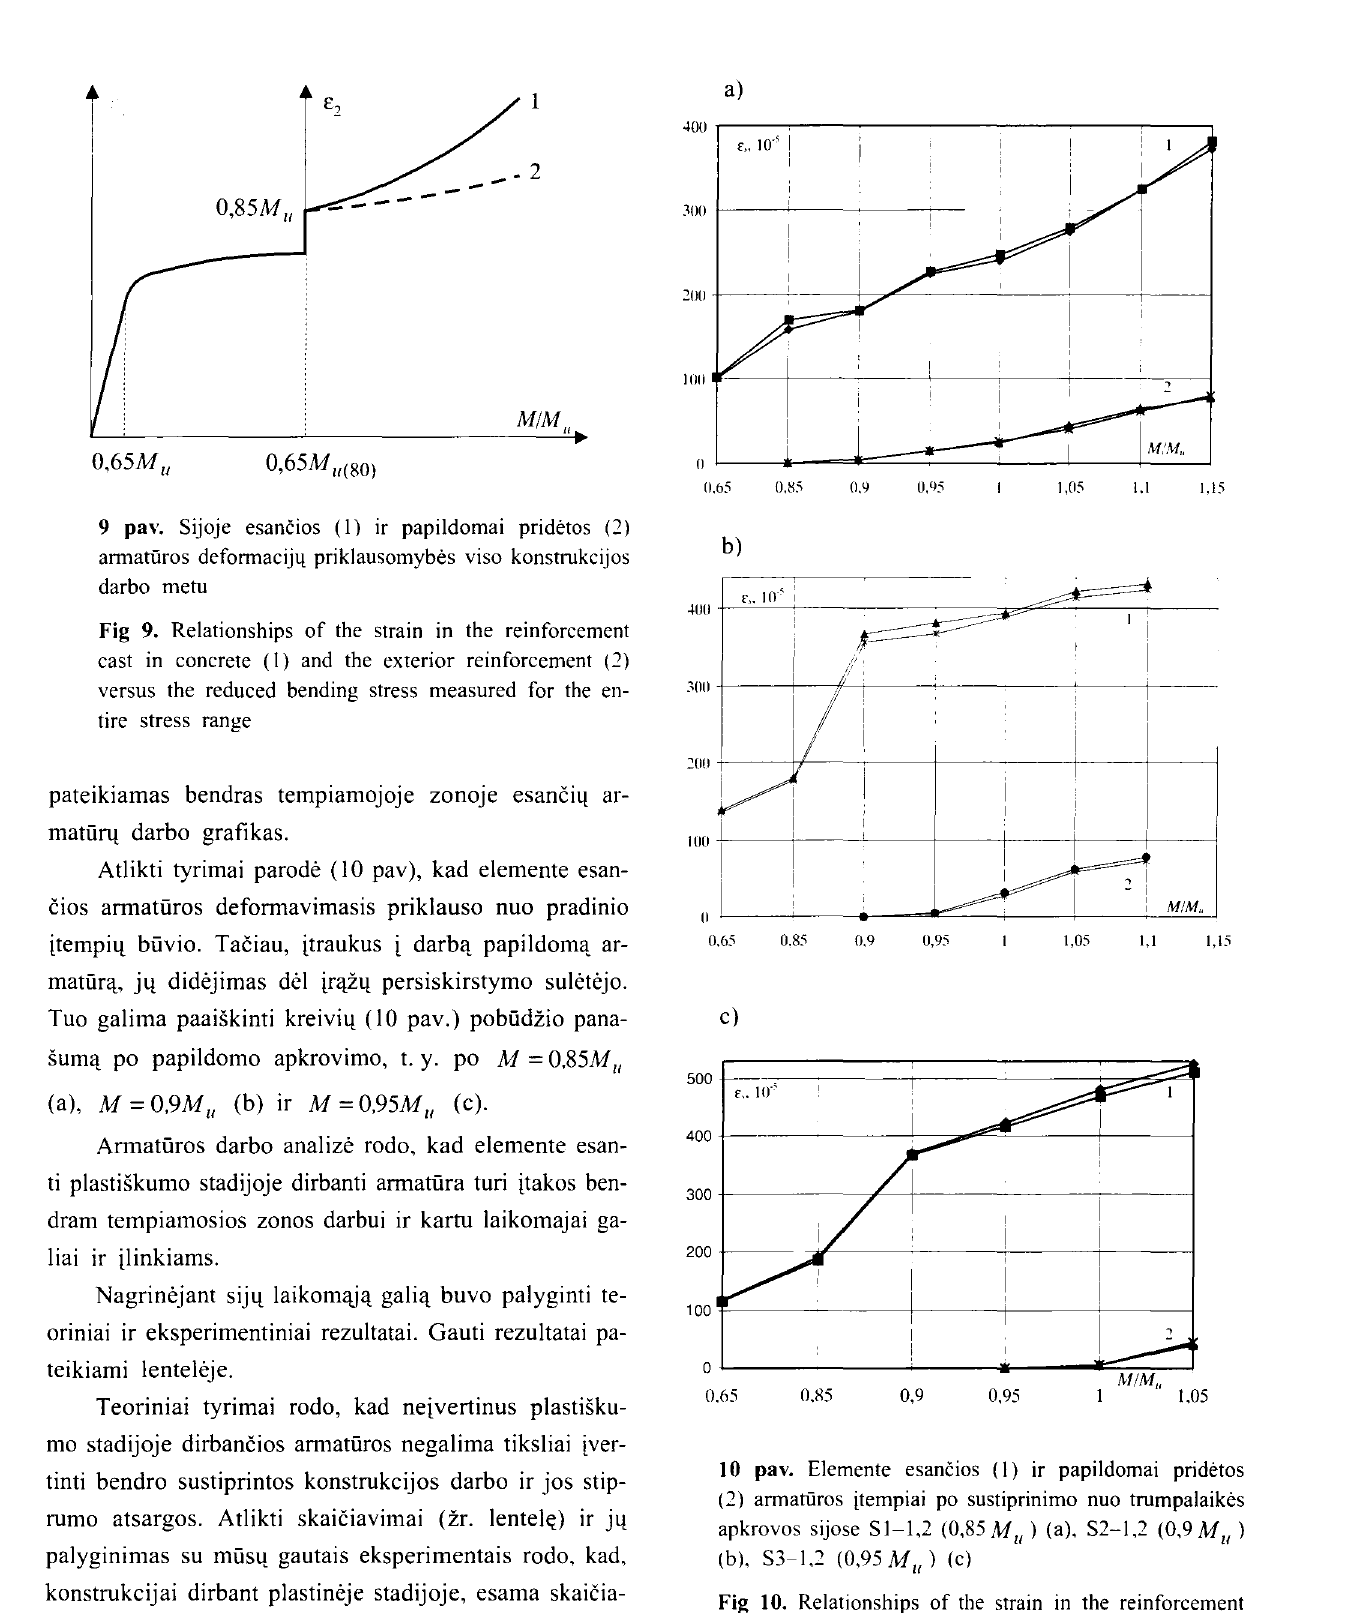
(2) armatliros itempiai po sustiprinimo nuo trumpalaikes apkrovos sijose Sl-1,2 (0,85 M (a). S2-1,2 (0,9 M 11 ) 11 ) (b). S3-L2 (0.95 M (c) 11 ) Fig 10. Relationships of the strain in the reinforcement cast in concrete (I) and the exterior reinforcement (2) versus the reduced bending stress measured during the application of short-term loads after strengthening: beams Sl-1,2 (0.85 M (a), beams S2-L2 (0.9 M (b), beams 11 ) 11 S3-l.2 (0.95 M 11 )